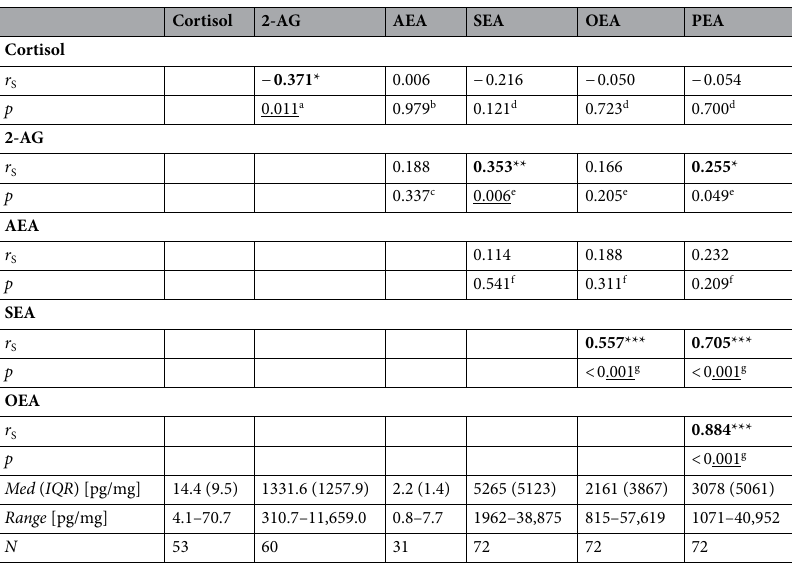
Table 3. Correlations and descriptive statistics of cortisol and endocannabinoid concentrations in hair. Spearman rank correlations ( r S ), * p < 0.050, ** p < 0.010, *** p < 0.001, two-tailed. Bold-faced correlations